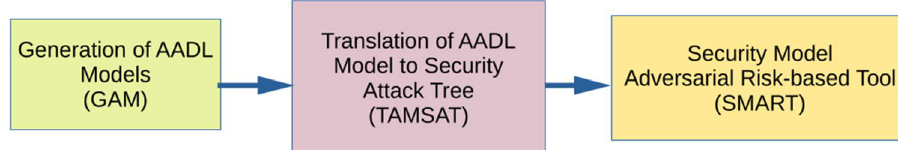
Fig. 1 Illustration of flow graph for the G-T-S